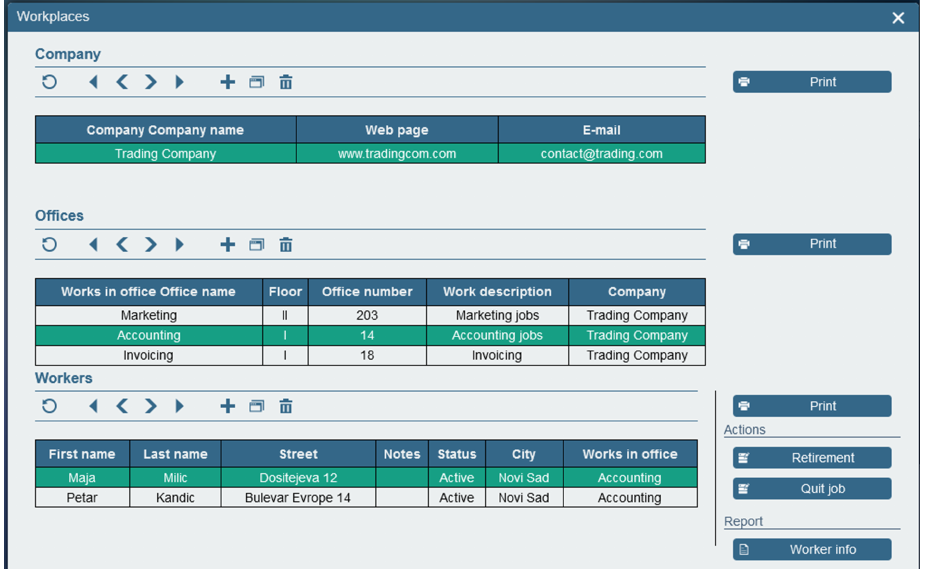
Figure 14. A parent-child web page of a